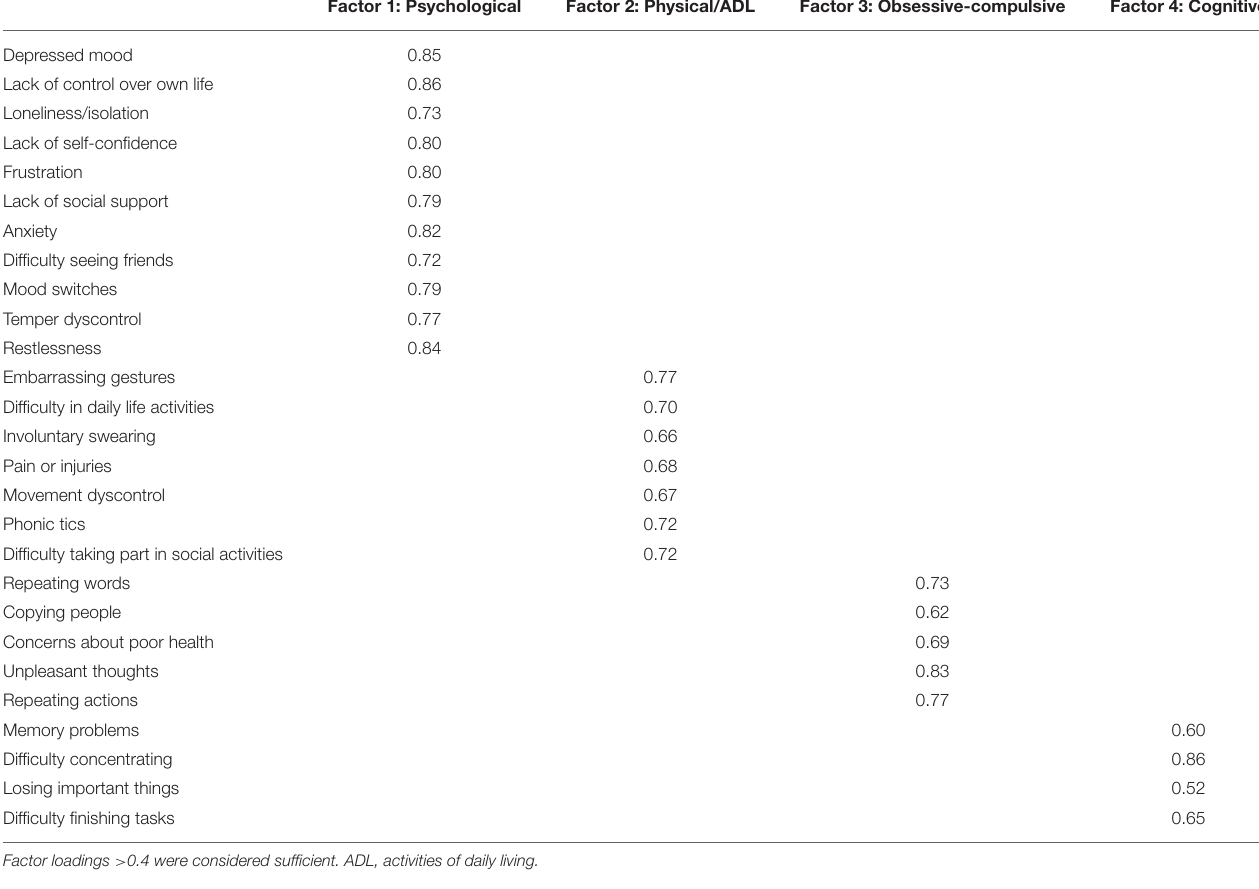
TABLE 2 | Factor loadings of each item after confirmatory factor analysis. Factor 1: Psychological Factor 2: Physical/ADL Factor 3: Obsessive-compulsive Factor 4: Cognitive